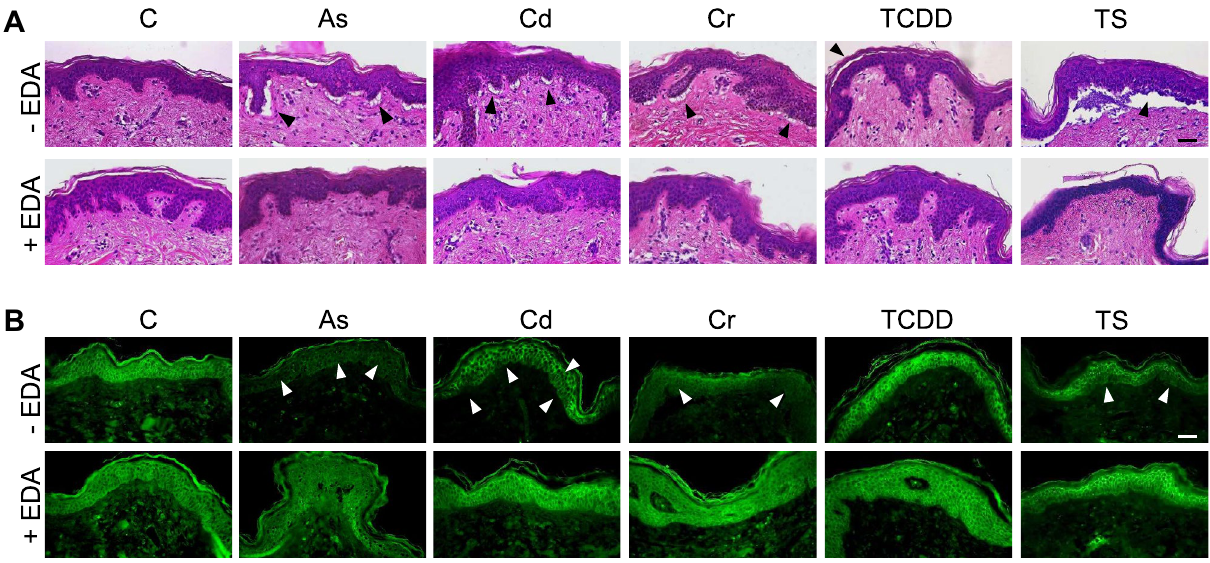
Figure 1. Deschampia antarctica aqueous extract (Edafence) efficiently prevents the structural tissue damage induced by acute exposure of Human Skin Organ Cultures to common ambient pollutants. HSOC histological sections from control samples (C) or samples exposed to As(III), Cd(II), Cr(VI), 2,3,7,8-tetrachlorodibenzo- p-dioxin (TCDD) or Tobacco Smoke culture medium infusions (TS) pre-treated or not with Deschampia antarctica aqueous extracts (EDA) showing ( A ) overall tissue morphology after H&E staining (black arrowheads point to major structural alterations in the tissue) and ( B ) fluorescent immunolocalization of the E-cadherin epidermal cell–cell adhesion marker (white arrowheads highlight representative areas of protein downregulation/delocalization in the tissue). Images are representative of at least three different samples for each experimental condition. Bars: 100